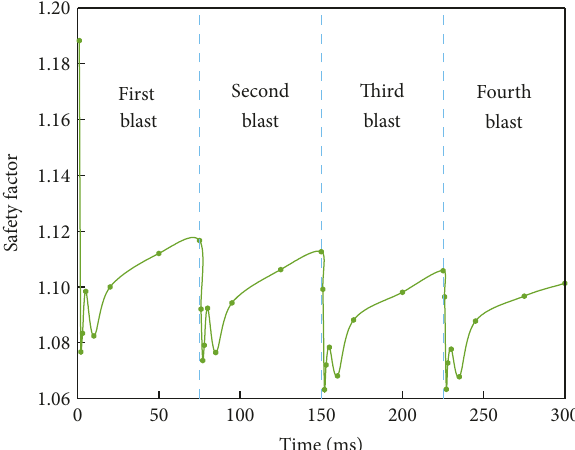
Figure 15: Change of the safety factor of the entire process of millisecond blasting.